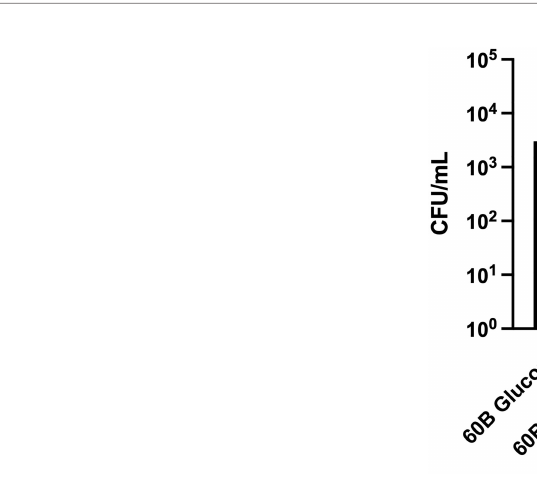
FIGURE 7 | Adherence of 60B and 60CSF to Detroit 562 cells. S. pneumoniae strains 60B and 60CSF at OD 600 0.2 were inoculated onto monolayers of Detroit 562 cells in CDM + glucose or CDM + galactose, and incubated for 2 h before being tested for adherent bacteria. Data are mean adherent bacteria ± standard error mean (SEM) from three independent assays, each performed in triplicate. Statistical analysis was performed using two-tailed Student ’ s t test. No signi fi cant differences were detected between the adherence of the strains in different